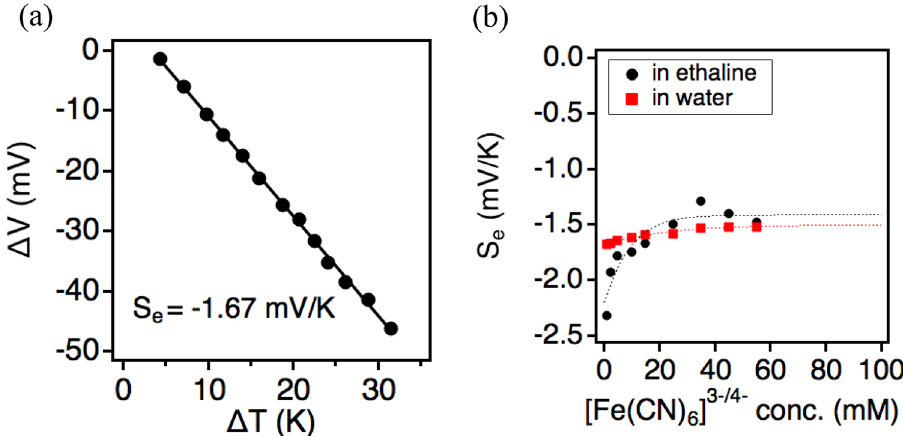
Figure 2. Seebeck coefficient of the ethaline thermocell. ( a ) The plot of open-circuit voltage against the temperature difference of the thermocell consisting of ethaline as a solvent and 15 mM of the redox species [Fe(CN) 6 ] 4−/3− ( T hot = ca. 165 °C). ( b ) The concentration dependency of S e of the ethaline thermocell (black circles) and aqueous thermocell (red